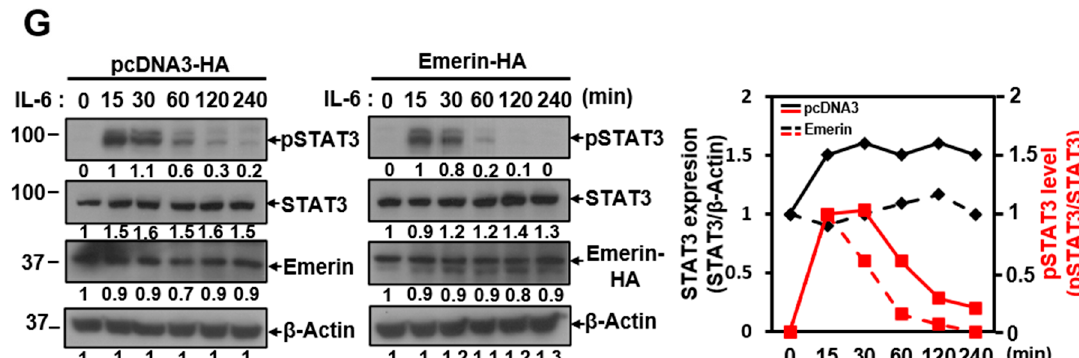
Figure 1. Emerin regulates the expression of STAT3 genes. ( A , C ) HeLa cells were transfected with vectors encoding Emerin-HA (1 µ g) in 6-well plates for 24 h. Total RNA was isolated and subjected to qRT-PCR analysis. Data were normalized to GAPDH expression. The results are presented the mean ± SD of three independent experiments performed in triplicate. ** p < 0.01. ( B , D ) HeLa cells were treated with siRNA (100 nM) against Emerin or control (si-Cont) for 48 h in 6-well plates. Total RNA was isolated and subjected to qRT-PCR analysis. Data were normalized to GAPDH expression. The results are presented as the mean ± SD of three independent experiments performed in triplicate. * p < 0.05, ** p < 0.01. ( E ) HeLa cells were dual-infected with STAT3 lentiviral luciferase and Renilla lentiviral luciferase. Cells were selected by puromycin. HeLa cells were treated with increasing amounts of IL-6 (0–40 ng/mL) for 6 h before being transfected with vectors encoding Emerin-HA (1 µ g) for 24 h in 6-well plates. Cells were lysed and subject to a luciferase assay. The luciferase reporter activity in each sample was normalized to a Renilla protein activity. R.L.U., relative luciferase units. The results are the mean ± SD of three independent experiments performed in triplicate. ** p < 0.01. ( F ) HeLa cells were treated with siRNA (100 nM) against Emerin or control (si-Cont) for 48 h in 6-well plates. Treated cells were lysed and subjected to Western blotting with antibody against emerin, NICD, STAT3, Bcl2, and β -actin. The membranes were analyzed using ImageJ software (NIH, Bethesda, NY, USA). ( G ) We treated 50% confluent HeLa cells with IL-6 (40 ng/mL) for the indicated times in 6-well plates. Treated cells were lysed and subjected to Western blotting with antibodies against STAT3, p-STAT3, emerin, HA-epitope, and β -actin. The membranes were analyzed using ImageJ software (NIH, Bethesda, NY, USA). Intensities of STAT3 and pSTAT3 in control vector transfection (left panel) and Emerin-HA transfection (right panel) were analyzed 16 h after transfection, including IL-6 treatment